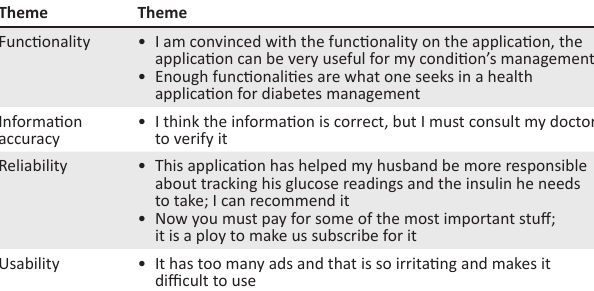
TABLE 2: Themes and associated sample